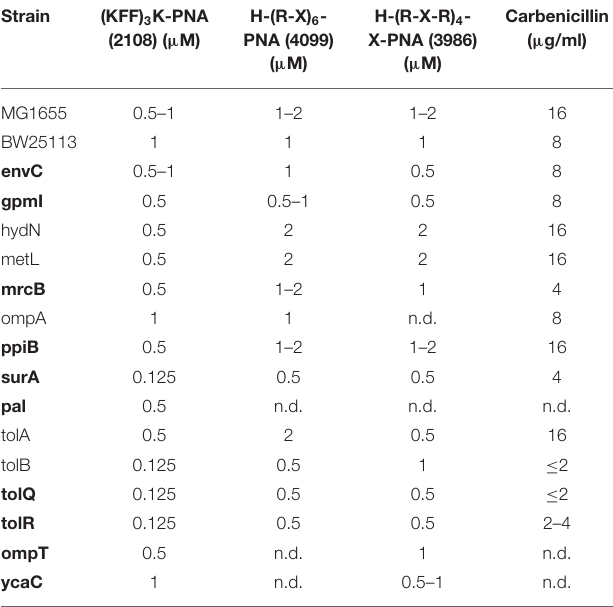
TABLE 4 | MIC values of permeable E. coli BW25113 mutants from the Keio collection (8).